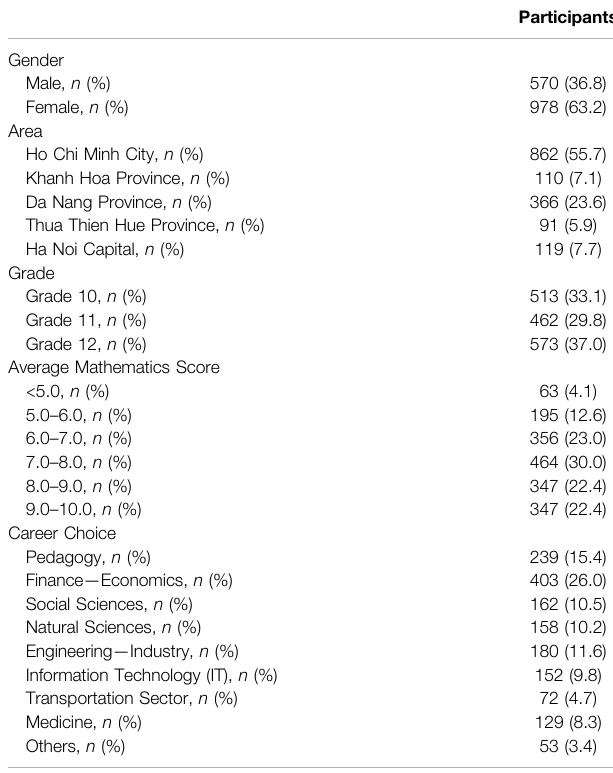
TABLE 1 | Socio-demographic characteristics of subjects ( N (cid:1) 1,548).